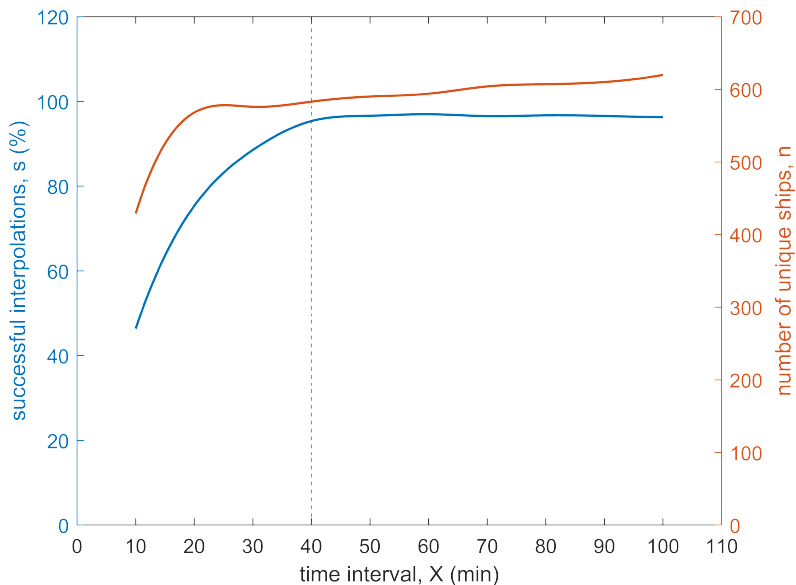
Figure 10. English Channel time interval selection ( X = 40